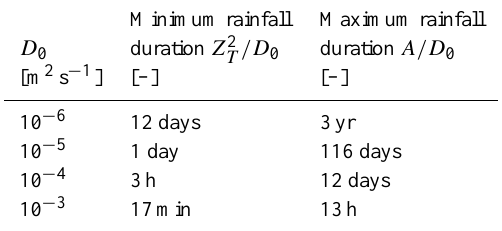
Table 2. Timescales of pore pressures transmission in response to rainfall, assuming Z T ∼ 1m and A ∼ 100m 2 .